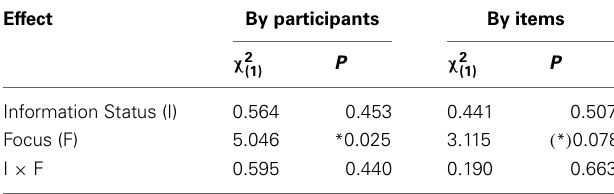
Table 5 | Generalized-Score Chi-Squares from binary logistic GEE analyses, predicting the likelihood of get-passive responses by factor combinations of Information Status (given Agent or given Patient) and Focus (Agent or Patient